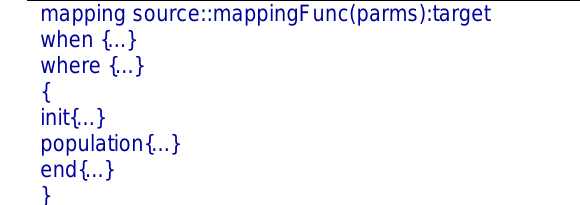
Fig. 2. Model-Driven Architecture (MDA) overview